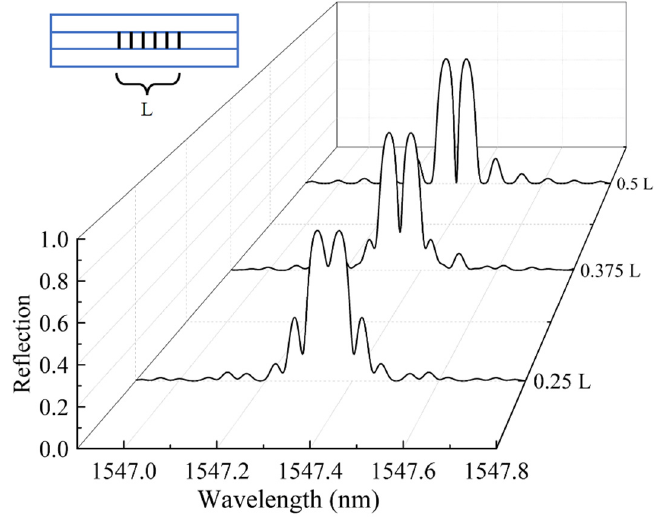
Figure 3. Reflection spectra of three π -PS-FBGs with different phase shift position.